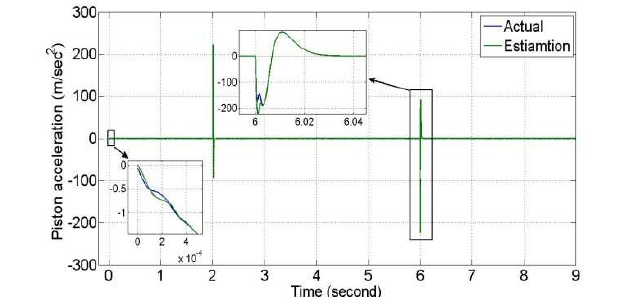
Fig. 11. Closed loop piston velocity parametric uncertainties with desired piecewise piston position. (cid:159) = (cid:160). £